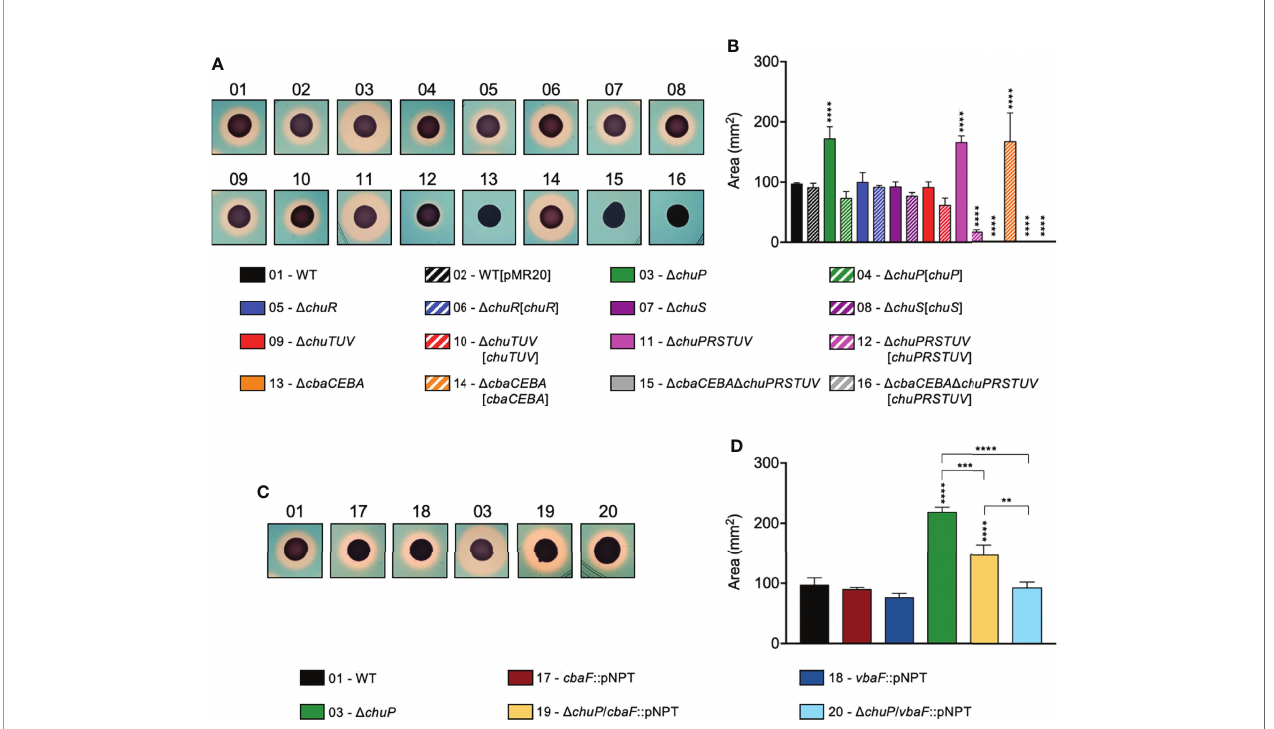
FIGURE 3 | Deletion of chuP impacts the siderophore levels in C. violaceum . (A, B) Role of the chu operon on the siderophore levels in C. violaceum . Mutant strains without chuP showed increased siderophore halos. (C, D) The effect of ChuP occurs on the siderophore viobactin. For all indicated strains, the siderophore detection was performed by CAS assays on PSA-CAS plates. C. violaceum cultures were spotted onto the plate surface, and the orange halos indicating secreted siderophores were photographed (A, C) and measured (B, D) , after incubation for 24 hours at 37°C, using Image J software. The area of the siderophore halos was calculated subtracting the area of bacterial growth. Data are from three biological replicates. Mutant and complemented strains (B) were compared to WT and WT [pMR20], respectively. Insertion mutants (D) were compared to the strains they derived from. **p < 0.01; ***p < 0.001; ****p < 0.0001; when not indicated, not signi fi cant. Vertical asterisks indicate comparisons with the WT strain. One-way ANOVA followed by Tukey ’ s multiple-comparison